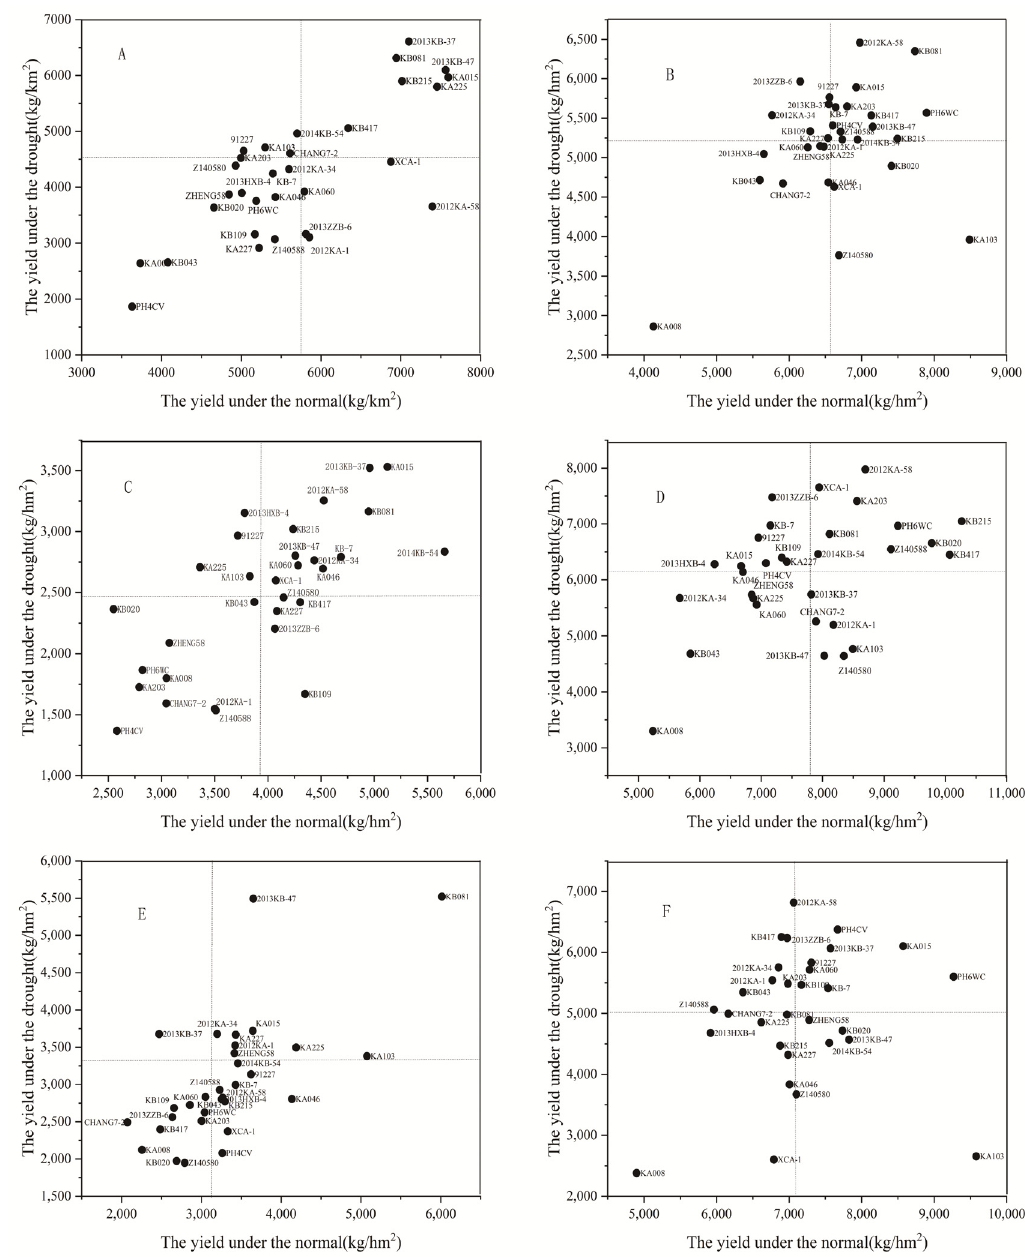
Figure 1. Scatterplots showing the yield under drought and normal conditions: ( A ) Yangling in 2015, ( B ) Yulin in 2015, ( C ) Yangling in 2016, ( D ) Yulin in 2016, ( E ) Yangling in 2017, ( F ) Yulin in